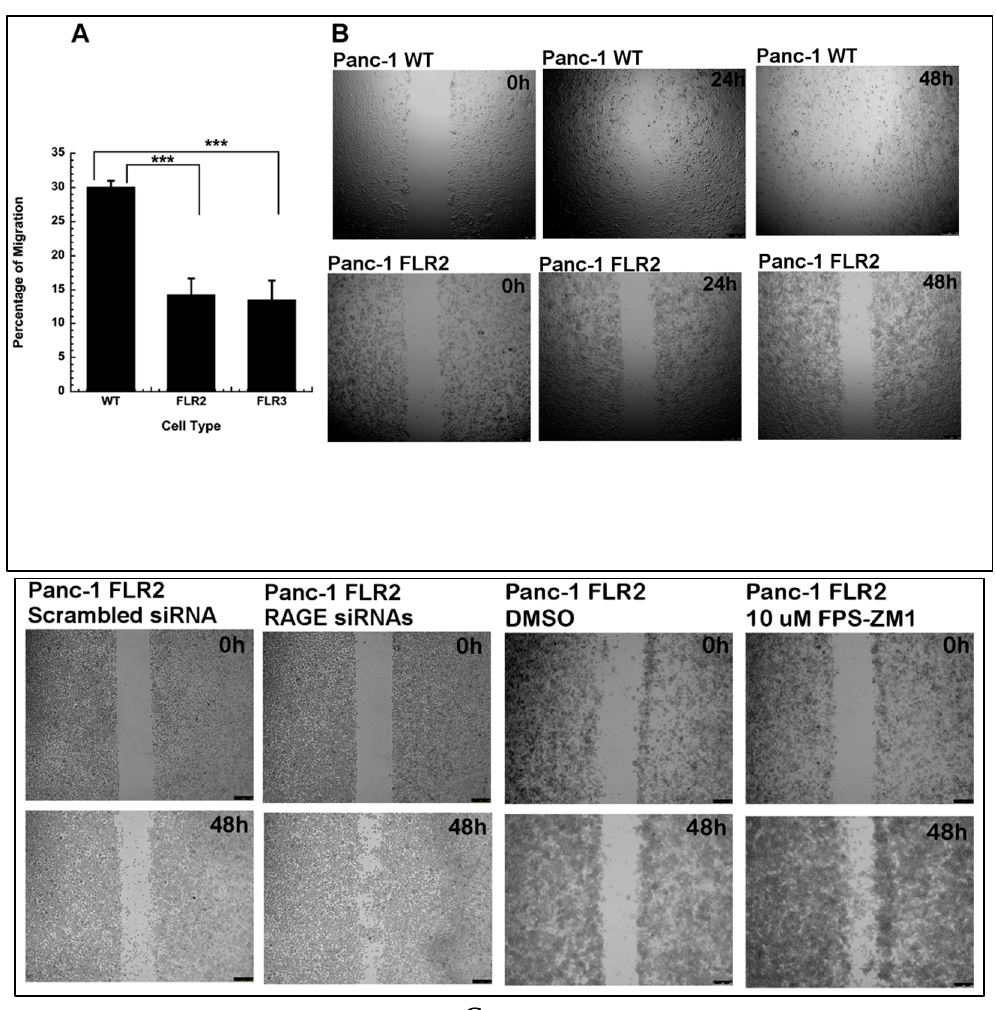
Figure 2. ( A , B ) RAGE expression decreases cell migration in FLR2 Panc-1 cells. Cell migration was assessed using the Boyden chamber migration assay. The percentage of migrated cells 24 h after seeding was estimated using resazurin. ( B ) RAGE expression reduces wound healing in FLR2 Panc-1 cells assay with WT and FLR2 Panc-1 cells. Cells were images at 0 h, 24 h, and 48 h following the formation of the wound. Representative images are shown. ( C ) RAGE silencing in FLR2 Panc-1 cells reverses wound healing inhibition in FLR2 Panc-1 cells. Wound healing assay with FLR2 Panc-1 cells that had been either transfected with RAGE specific siRNAs or scrambled siRNAs, or treated with either vehicle (0.2% DMSO) or 10 µ M FPS-ZM1. Images were taken at t = 0 h and t = 48 h. Representative images are shown. *** p < 0.001.